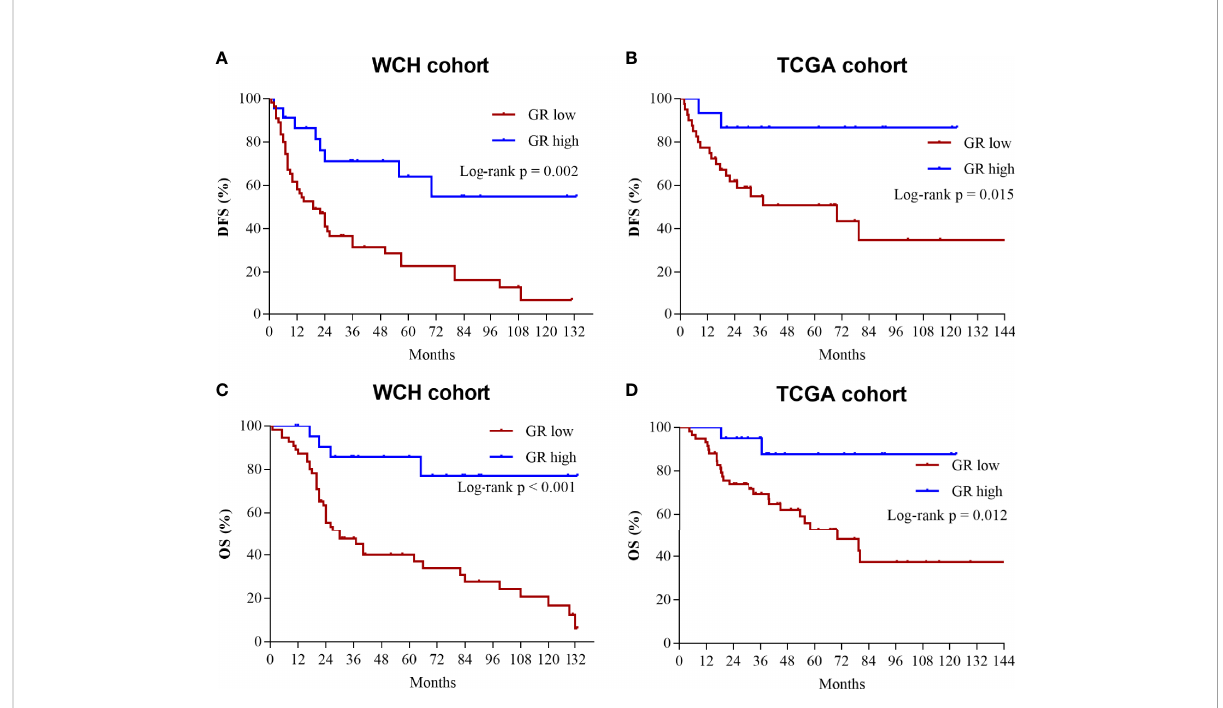
FIGURE 5 Low levels of GR predict worse prognosis in ACC patients. (A) Cumulative overall survival curves of patients from the WCH cohort with high or low GR expression levels. (B) Cumulative disease-free survival curves of patients from the WCH cohort with high or low GR expression levels. (C) Cumulative overall survival curves of patients from the TCGA cohort with high or low GR expression levels. (D) Cumulative disease-free survival curves of patients from the TCGA cohort with high or low GR expression